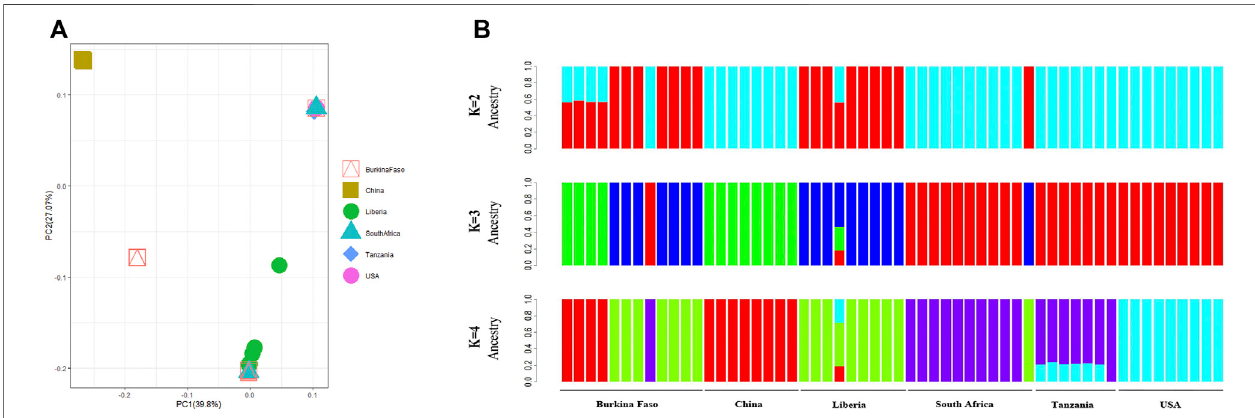
FIGURE2| Structureanalysisofthebeetles. (A) PCAplotofthestudied beetles.ThebeetlesinChinaweredistantfromtheonesinnativeandestablished regions. (B) Ancestral population inference of the studied beetles. The beetles in China may share an ancestor with the ones in Burkina Faso.